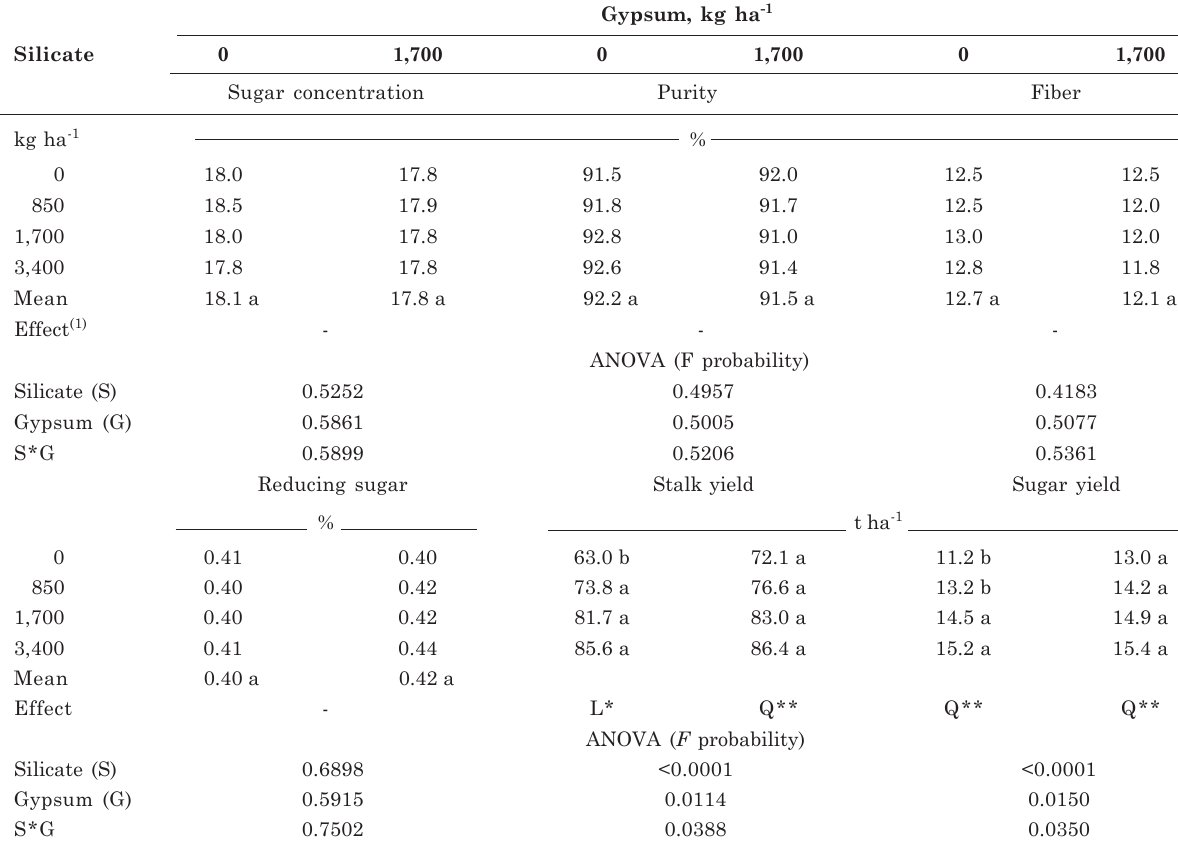
Table 4. Values of sugar concentration, purity, fiber, reducing sugar, and stalk and sugar yield taken